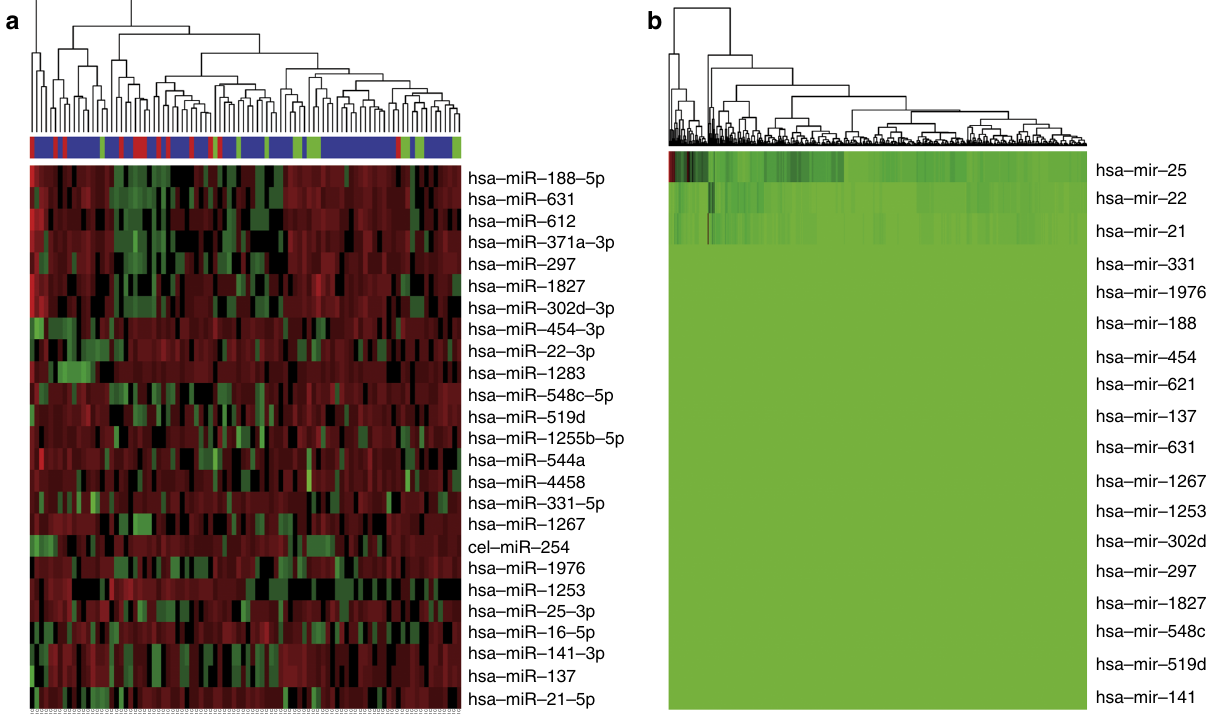
Fig. 4 Differentially expressed microRNA. a Unsupervised clustering of the 24 microRNAs that were differentially expressed between cases with and without STIC lesions at a corrected P value < 0.01. b The previously published TCGA data showing that all but three of these genes have low